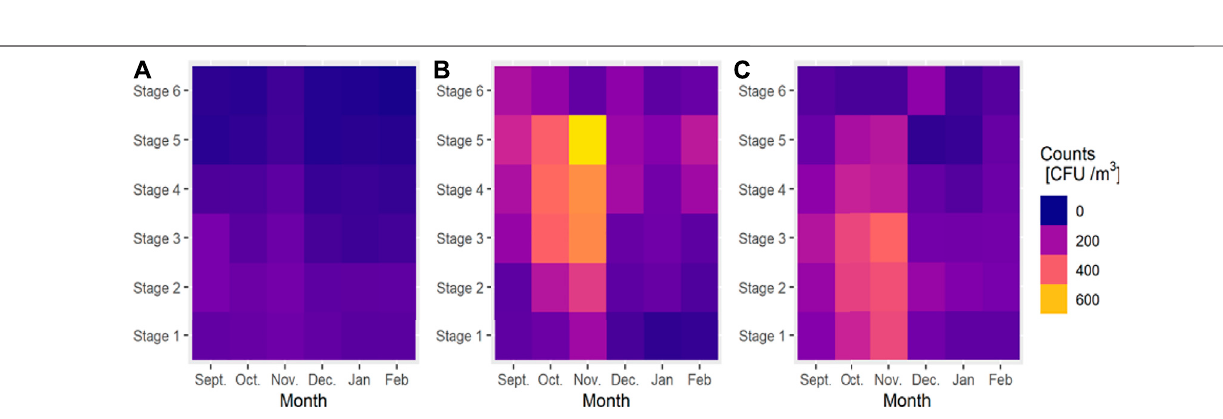
FIGURE2| Thesizedistribution ofbacterialaerosolcollectedbyusinganAndersenimpactorwithdifferentaerodynamicdiameterstages: stage1: > 7.0 µm;stage 2: 4.7 – 7.0 µm; stage 3: 3.3 – 4.7 µm; stage 4: 2.1 – 3.3 µm; stage 5: 1.1 – 2.1 µm; stage 6: 0.65 – 1.1 µm; (A) outdoor environment (OUT); (B) when AP was off (APO); (C) when AP was active